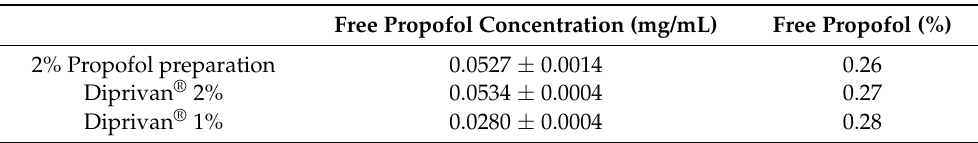
Free propofol in the in-house prepared NE in comparison with commercialized Diprivan ®